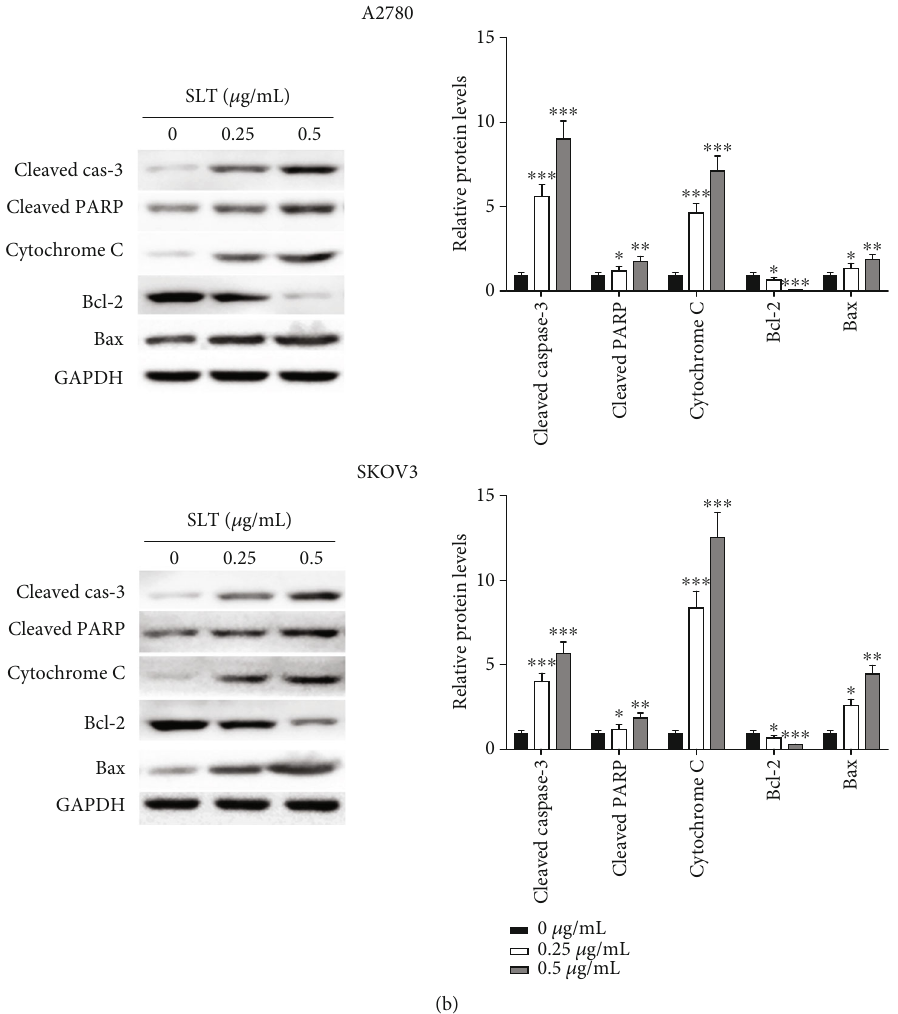
Figure 3: The e ff ects of SLT on apoptosis of ovarian cancer cells. (a) The e ff ects of SLT on cell apoptosis of A2780 and SKOV3 cells were analyzed via Annexin V-FITC/PI double staining assay. (b) The e ff ects of SLT on the expression levels of apoptosis-related protein in A2780 and SKOV3 cells were evaluated via western blot assay. The values were displayed as the mean ± SD . Representative results from three independent experiments were shown ( ∗ P < 0 : 05 , ∗∗ P < 0 : 01 , and ∗∗∗ P < 0 : 001 , compared with the control